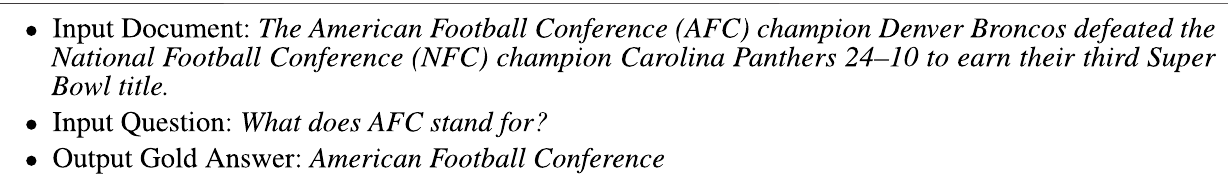
FIGURE 3 | An example of the SQuAD (Stanford Question Answering Dataset) Task. The gold answer is a span, a substring from the input document.